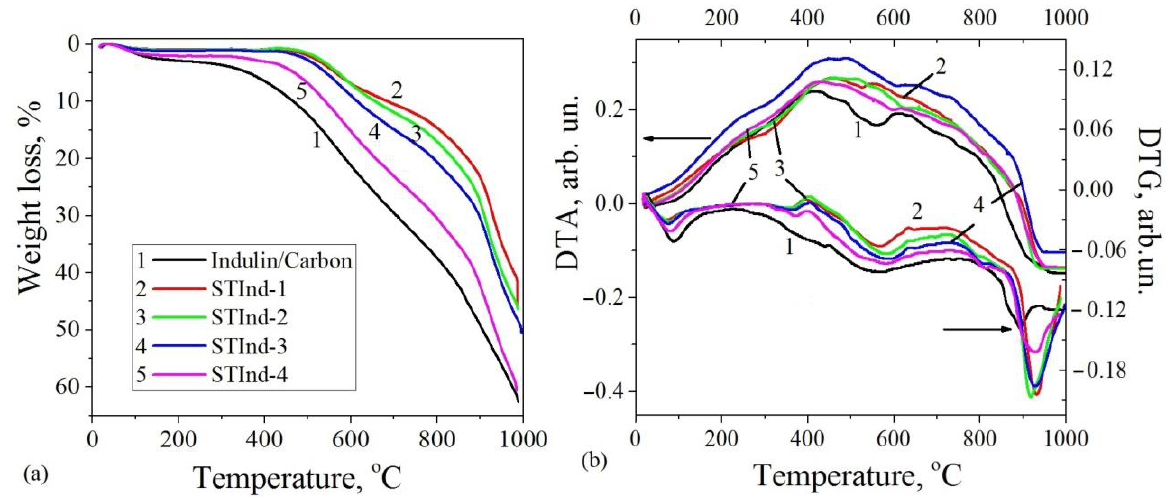
Figure 3. TG ( a ) and DTG and DTA ( b ) curves of biochars.